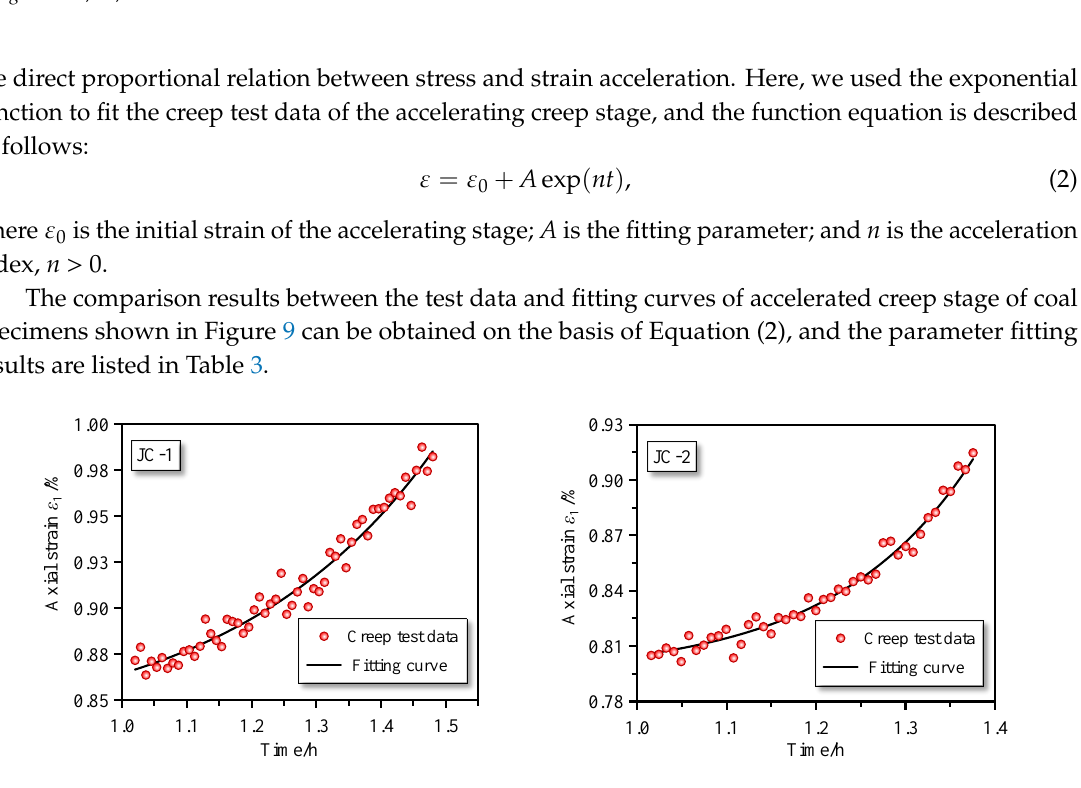
Figure 9. Comparison between creep test data and fitting curves of accelerating creep stage of coal specimens. Table 3. Parameter identification of accelerating creep stage